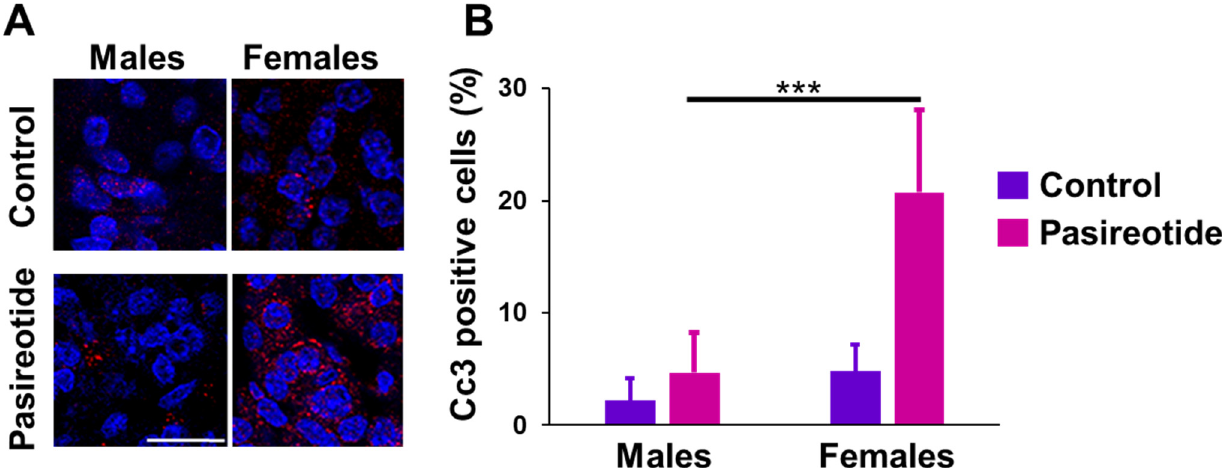
Figure 7. Cleaved caspase 3 (Cc3) expression in rat PTs. ( A ) Immunofluorescent staining of PT tissue sections of rats from the two groups (pasireotide-treated and control) were stained with an antibody against Cc3 (red). Nuclei were counterstained with Hoechst 33258 (blue). Shown are sections representative of the two treatment groups and of both genders ( n = 3/group/gender). Acquisition settings and magnification were the same for each picture. Original magnification: × 400. Size bar = 20 µ m. ( B ) Quantification of the number of Cc3-positive cells in tissues stained as shown in A ( n = 3/treatment group/sex) was performed as indicated in the Materials and Methods. Results are presented as the mean percentage of Cc3 positive cells ± SD. ***, p < 0.0001.